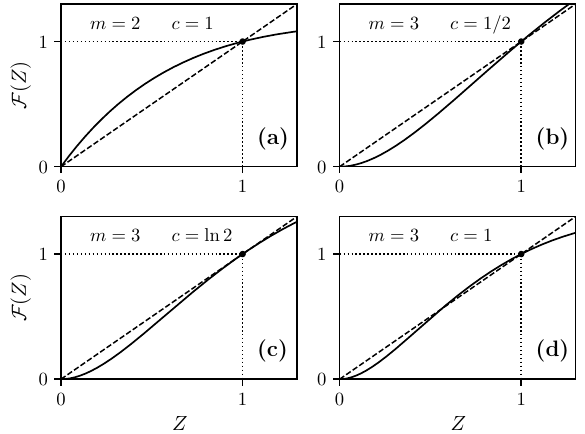
1 is always a fixed = 3 layers the stability transition =